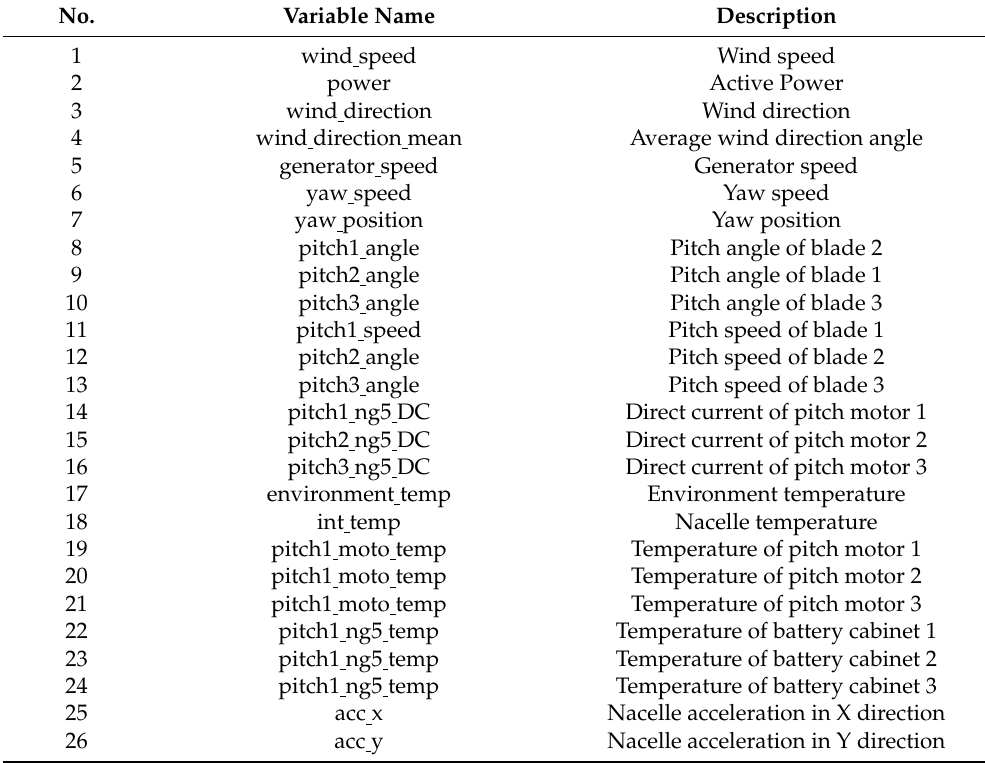
Table 1. Sensor variable information of the SCADA